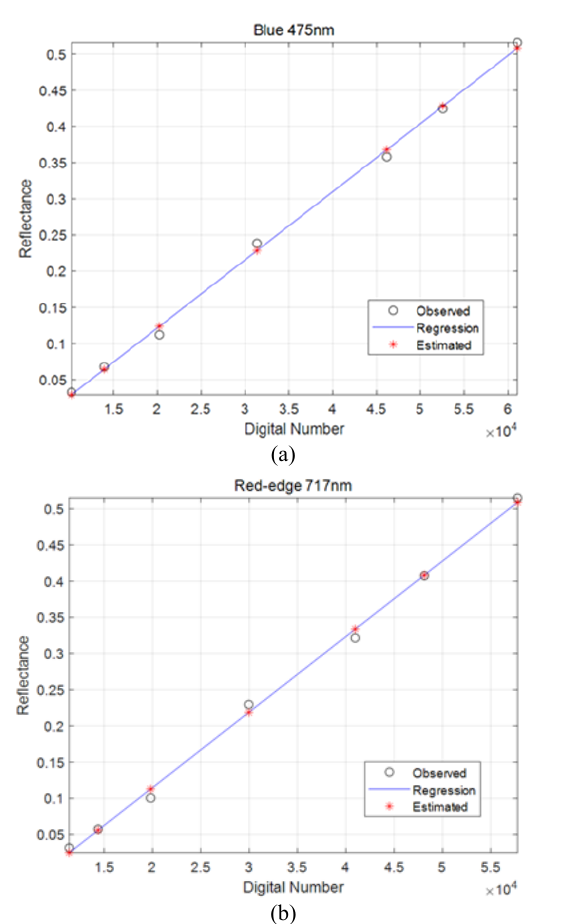
Figure 6. Examples of linear regression analysis between the digital number and the reflectance for (a) blue and (b) red-edge